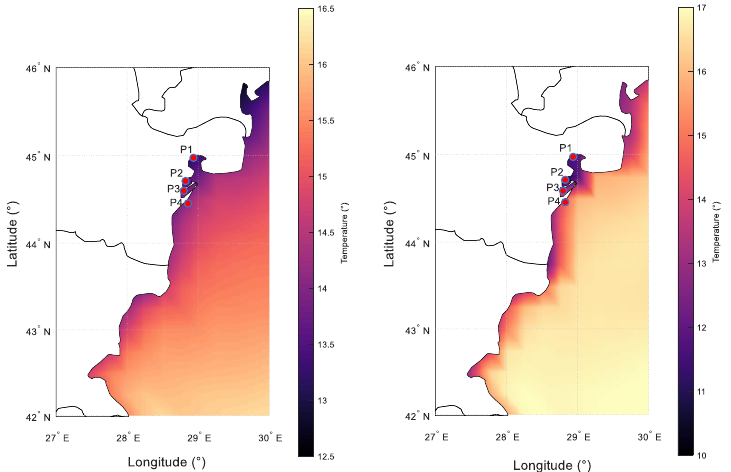
Figure 9. Map with the lakes of eastern Romania and the western Black Sea. The left side shows the air temperature and the right side shows the water temperature.